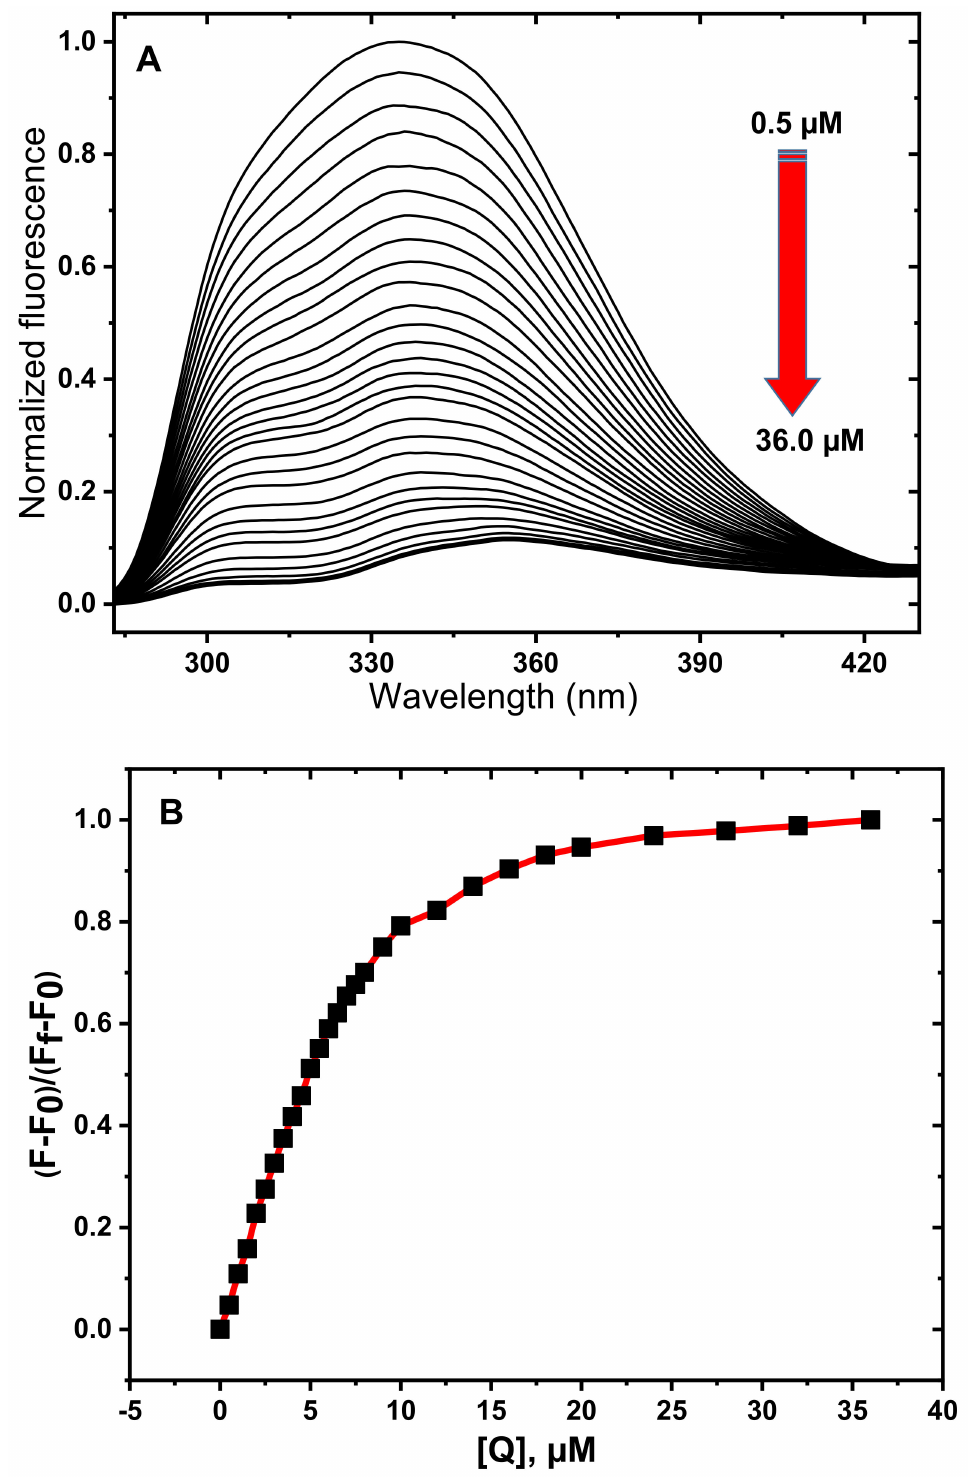
Figure 5. ( A ) Fluorescence spectra of 20.0 µ M human serum albumin (HSA) in the presence of PAZ with concentrations varying from 0.5 µ M to 36.0 µ M at pH 7.4 and 318.15 K. ( B ) Corresponding binding isotherm and fitting curve (F 0 : initial fluorescence intensity, F f : final fluorescence